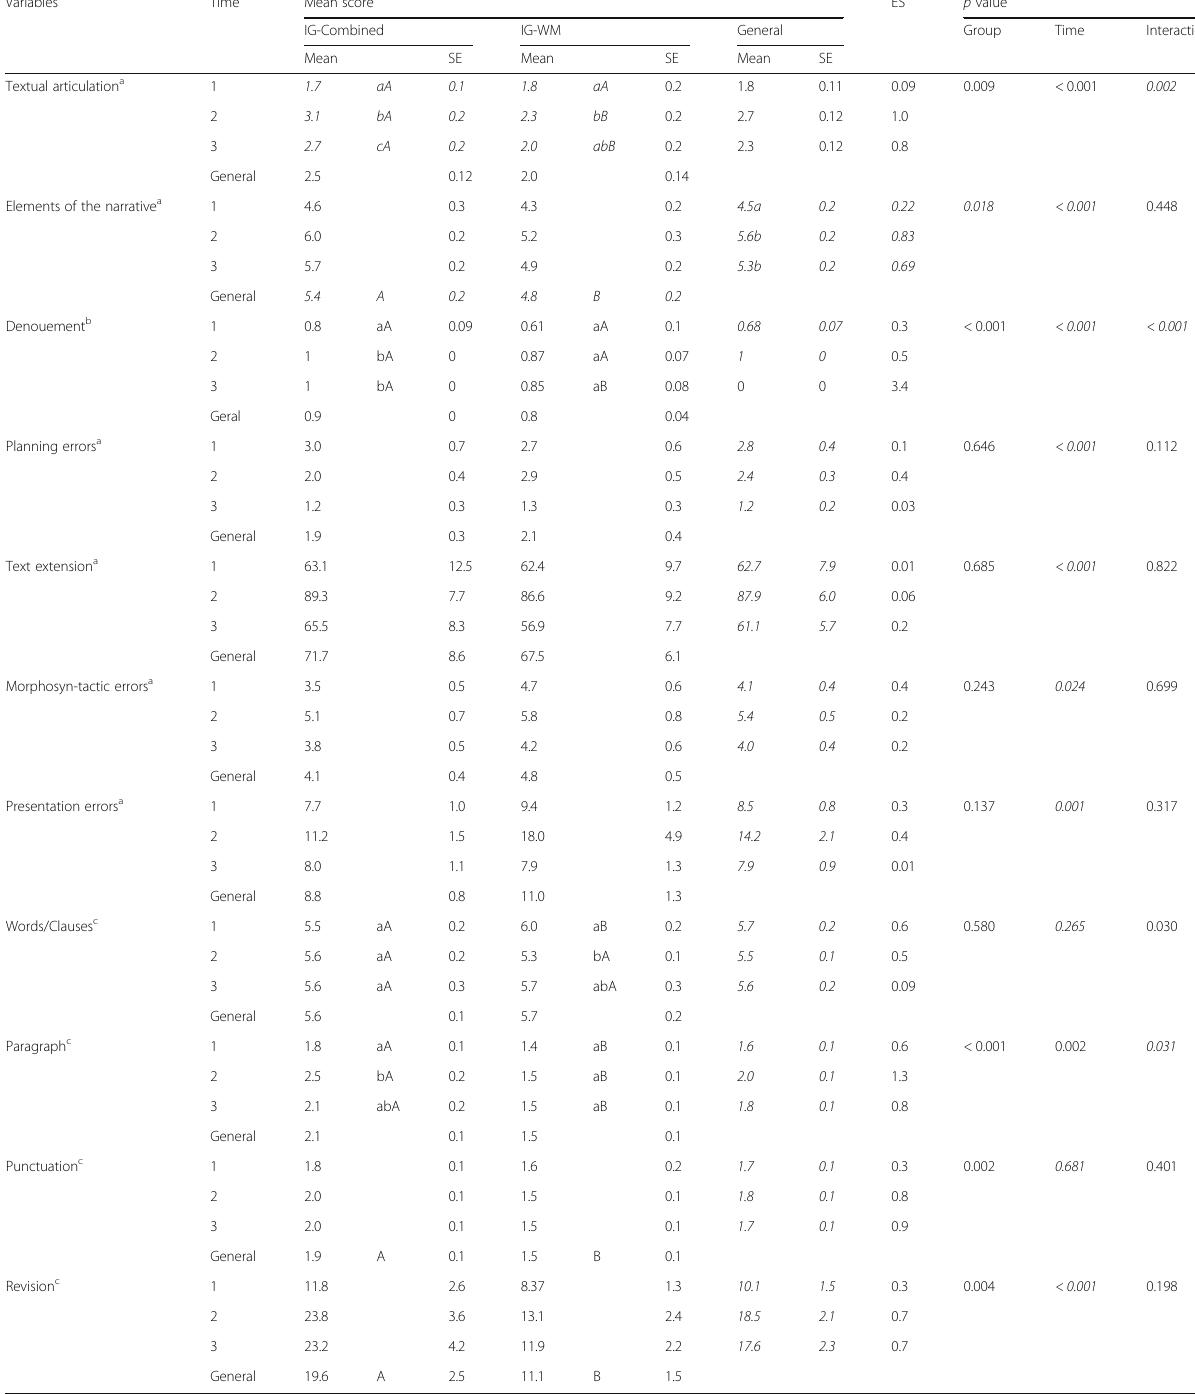
b Binary logit distribution c Normal